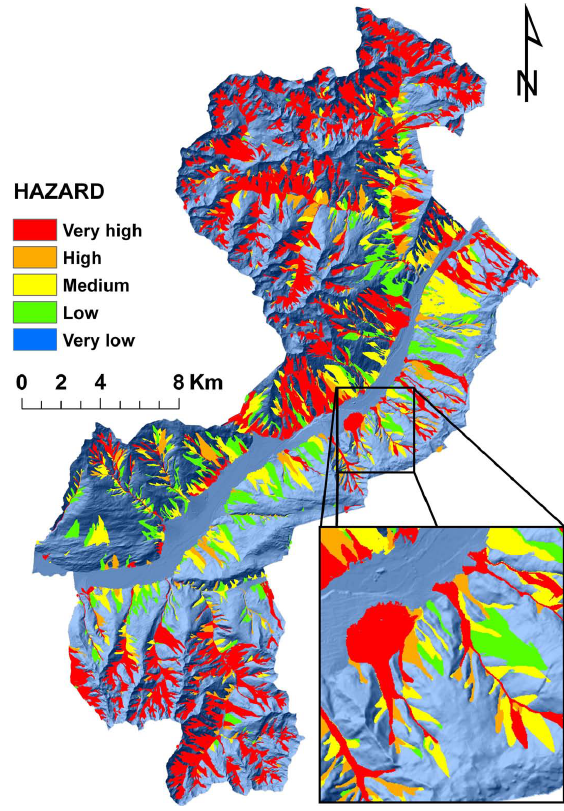
Fig. 8. Final debris flow hazard map A classified in five